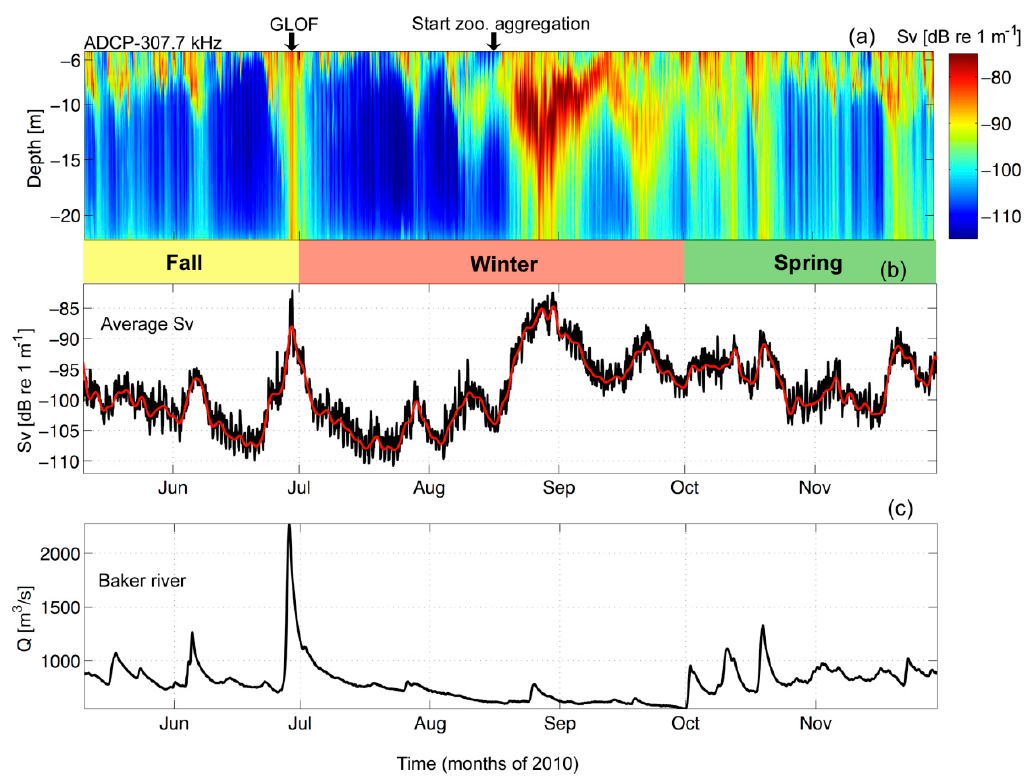
Figure 3. ( a ) Volume backscattering strength (Sv, in dB re 1 m − 1 ) from autumn to spring of 2010. ( b ) The depth average of Sv in black with the 30 h low-passed time series depicted by the center line. ( c ) Hourly Baker River discharge measurements (m 3 s − 1 ).